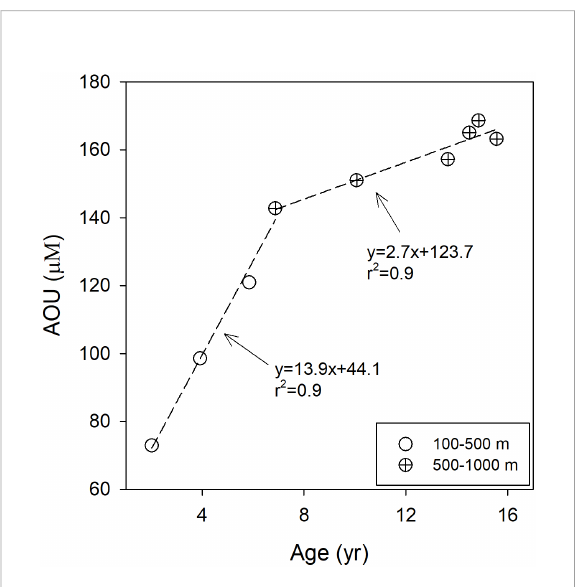
FIGURE 4 Water mass ages versus apparent oxygen utilization (AOU) from 100 to 1000 m in the Ulleung